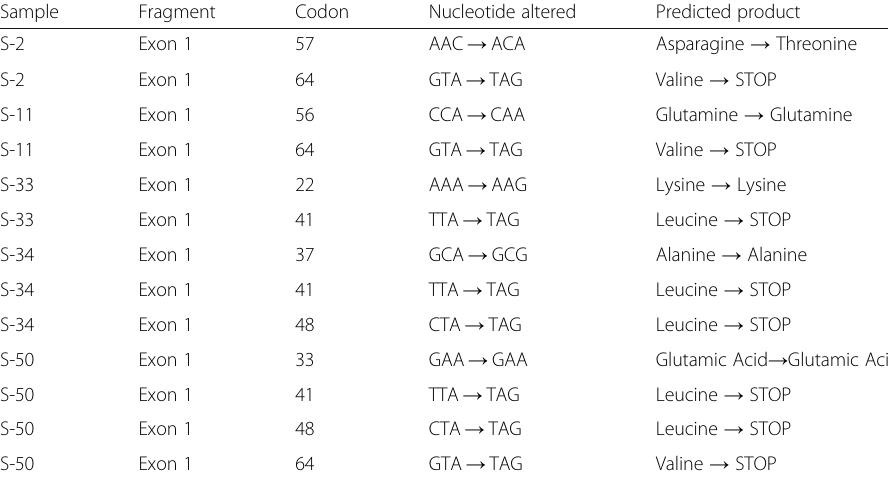
Table 1 Mutations in Exon 1 of TCF-4 gene in Tumor Samples Sample Fragment Codon